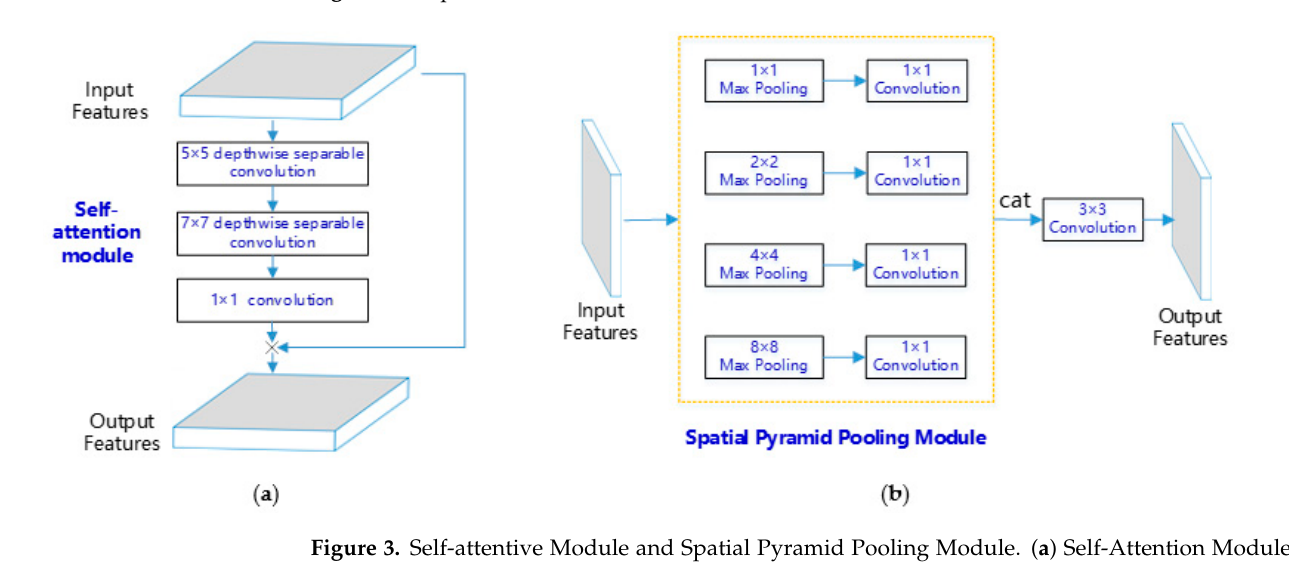
Figure 2. Proposed cloud detection module.